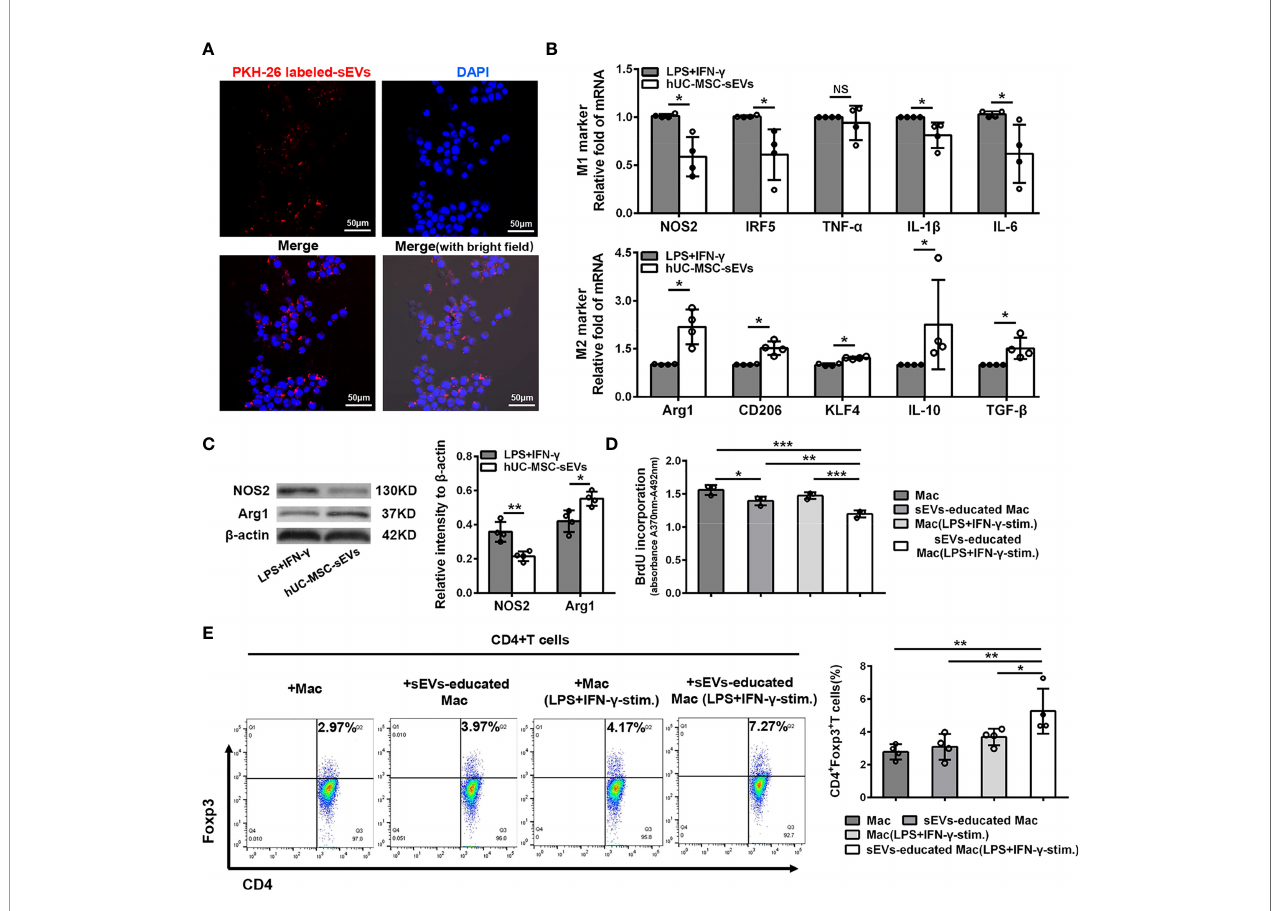
FIGURE 6 | hUC-MSC-sEVs converted in fl ammatory macrophages to M2 phenotype, which suppressed T cell proliferation and increased Treg frequency. (A) Representative images of the uptake of PKH-26-labeled hUC-MSC-sEVs (red) by human-monocyte-differentiated macrophages (called as Mac, DAPI blue). (B, C) LPS+IFN- g -stimulated Mac was co-cultured with or without 5 m g/ml hUC-MSC-sEVs for 48h. (B) Q-PCR analysis of M1 markers (NOS2, IRF5, TNF- a , IL-1 b and IL- 6) and M2 markers (Arg1, CD206, KLF4, IL-10 and TGF- b ). (C) Western blot assay for NOS2 and Arg1 protein level. (D, E) After incubated with hUC-MSC-sEVs, macrophages were collected and cultured together with human CD4+ T cells for 5 days in the presence of anti-CD3/-CD28 antibodies. (D) BrdU assay for CD4+ T cell proliferation. (E) Flow cytometric analysis for CD4+Foxp3+ T cells. sEVs, hUC-MSC-sEVs; LPS+IFN- g -stim., LPS+ IFN- g -stimulation. Representative data from at least three independent experiments were presented as mean± SD. *P < 0.05, **P < 0.01, ***P < 0.001, NS, not signi fi